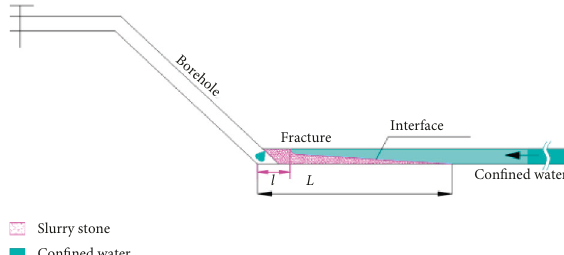
Figure 9: Verification of plugging effect by the second drilling. L is the diffusion distance of the slurry, and l is the effective water plugging